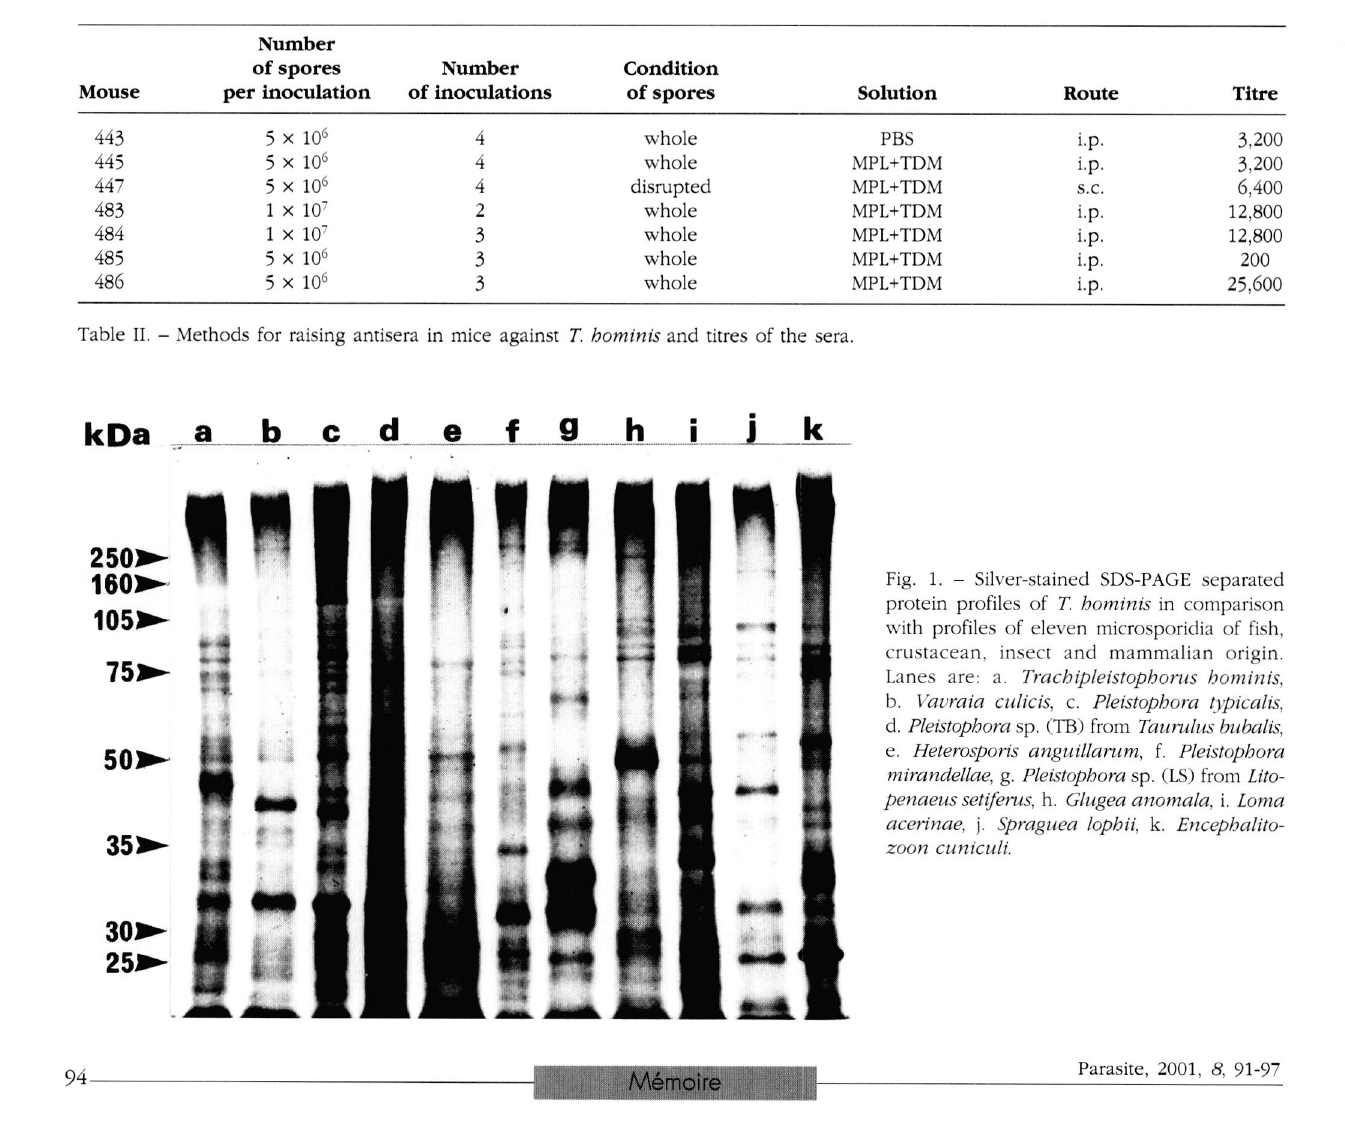
Table II. - Methods for raising antisera in mice against T. hominis and titres of the sera.